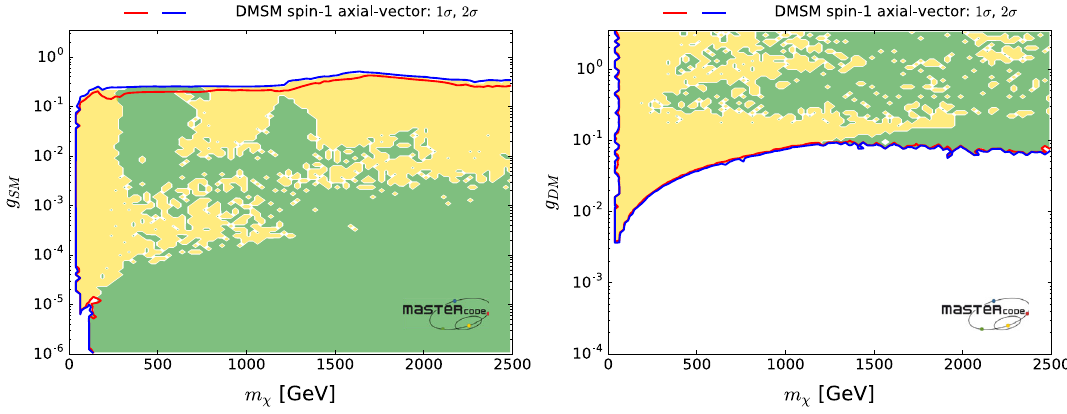
Fig. 12 The likelihood functions for g SM (left panel) and g DM (right panel) as functions of m χ in the model with axial-vector couplings. We again use colour coding to illustrate the dominant mechanisms bring- ing the DM density into the allowed range: green for annihilation via t -